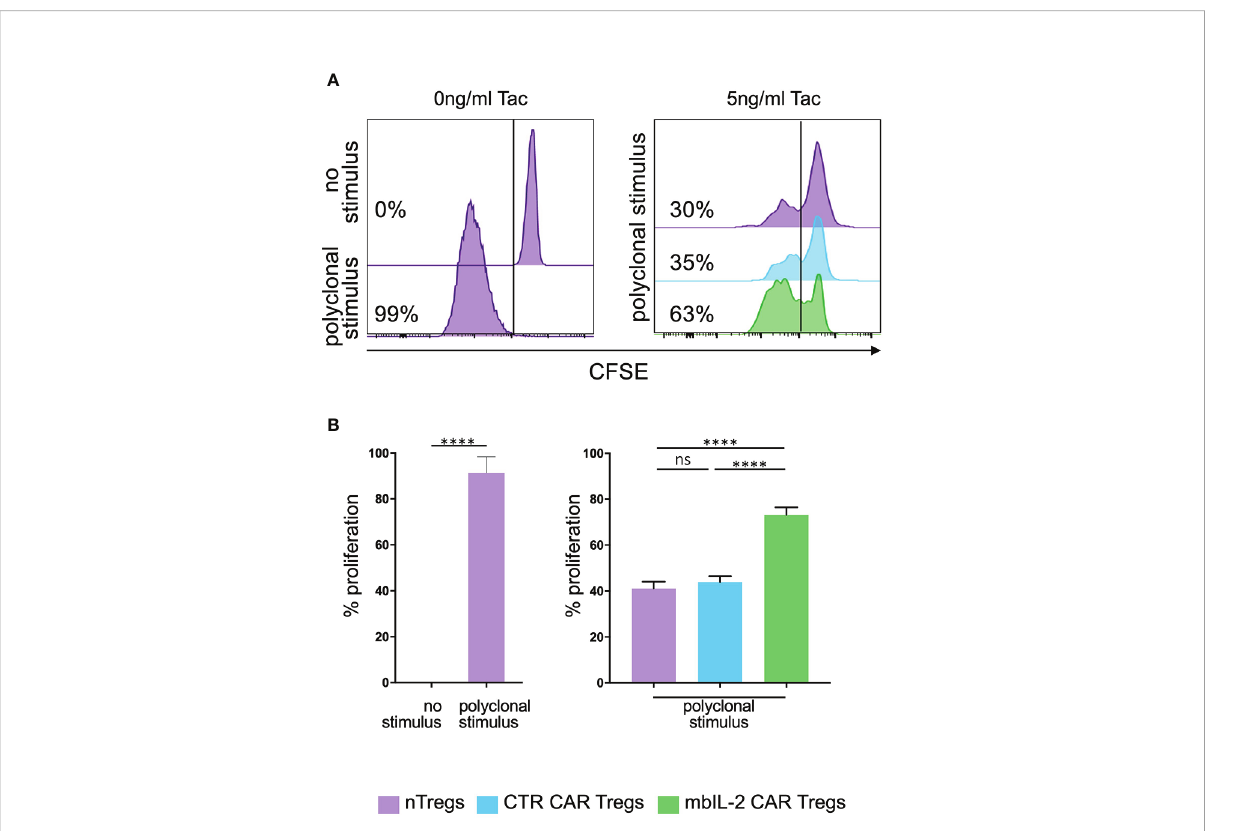
FIGURE 7 Expression of membrane-bound IL-2 protected against adverse effects of tacrolimus in vitro . (A) Representative histograms illustrating the proliferative capacity of polyclonally stimulated CTR CAR-Tregs and mbIL-2 CAR-Tregs in the presence of tacrolimus (Tac) and absence of exogenous IL-2. CTR CAR-Tregs and mbIL-2 CAR-Tregs were rested and labelled with a cell proliferation marker (CFSE). Left: representative histogram of unstimulated and polyclonal stimulated Tregs with no addition of Tac. Right: to assess proliferative capacity of mbIL-2 CAR Tregs after polyclonal stimulation in the presence of 5ng/ml tacrolimus, a CFSE dilution assay was performed. Cell proliferation was related to stimulated nTregs as well as to stimulated CTR CAR Tregs both under same conditions. (B) Bar graph summarizes all performed experiments. The proliferative capacity of mbIL-2 CAR-Tregs was signi fi cantly higher in the presence 5 ng/ml Tac (71% ± 4,9) in direct comparison to CTR CAR-Treg (44% ± 2,5; ***P value ⪬ 0,0002) as well as to nTregs proliferation (41,2% ± 2,9; ****P value ⪬ 0,0001). No signi fi cant difference was found in the proliferation capacity of CTR CAR Tregs and nTregs (ns= not signi fi cant, P Value= 0,8448). Each analysis was compared to proliferation analysed in nTregs, cocultivated with mbIL-2 CAR-Tregs. Error bars show the mean ± SEM. Signi fi cance was calculated using ordinary one-way ANOVA with Tukey ’ s multiple comparisons test (n=3, 4 different